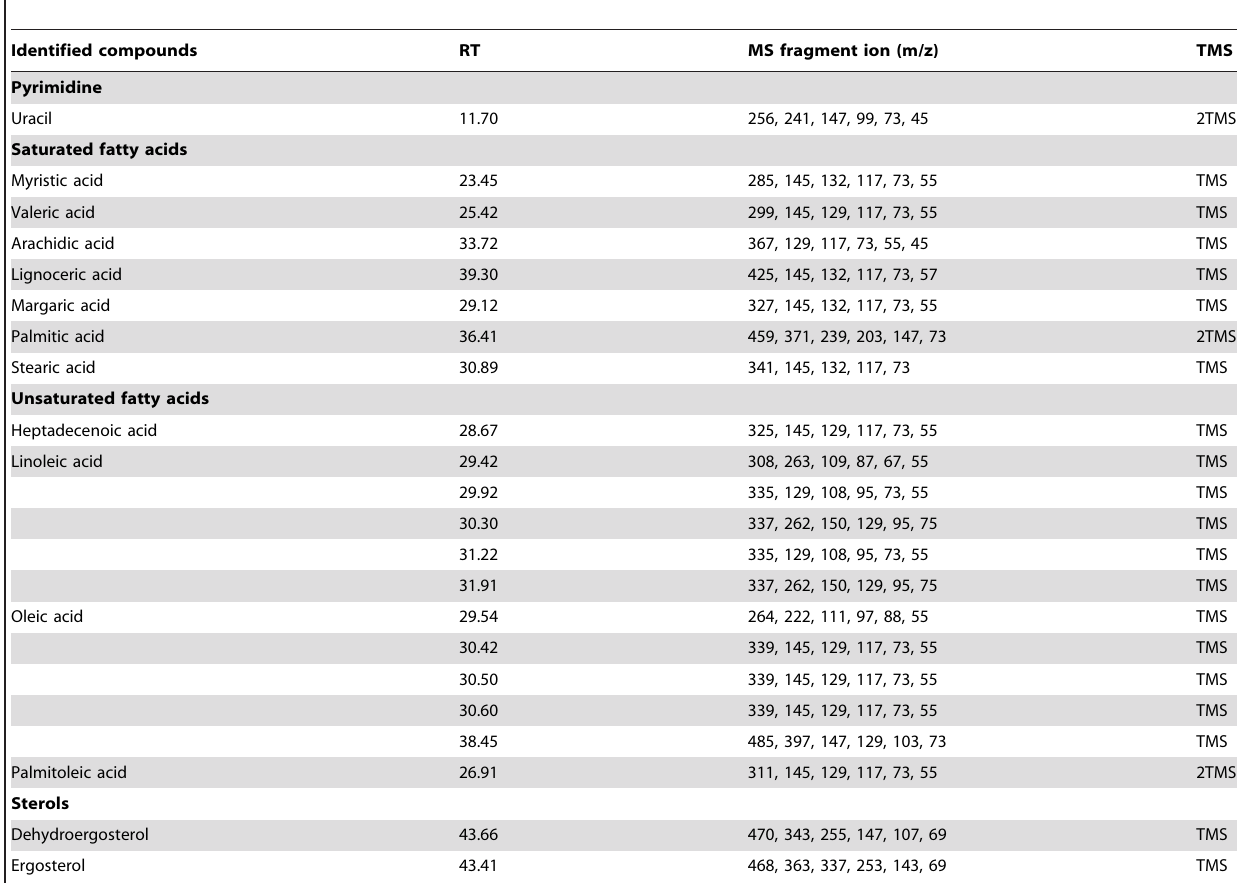
Table 4. Chromatographic data of the identified compounds from the 100% n -hexane extract of C. pruinosa mycelia analyzed using GC-MS.